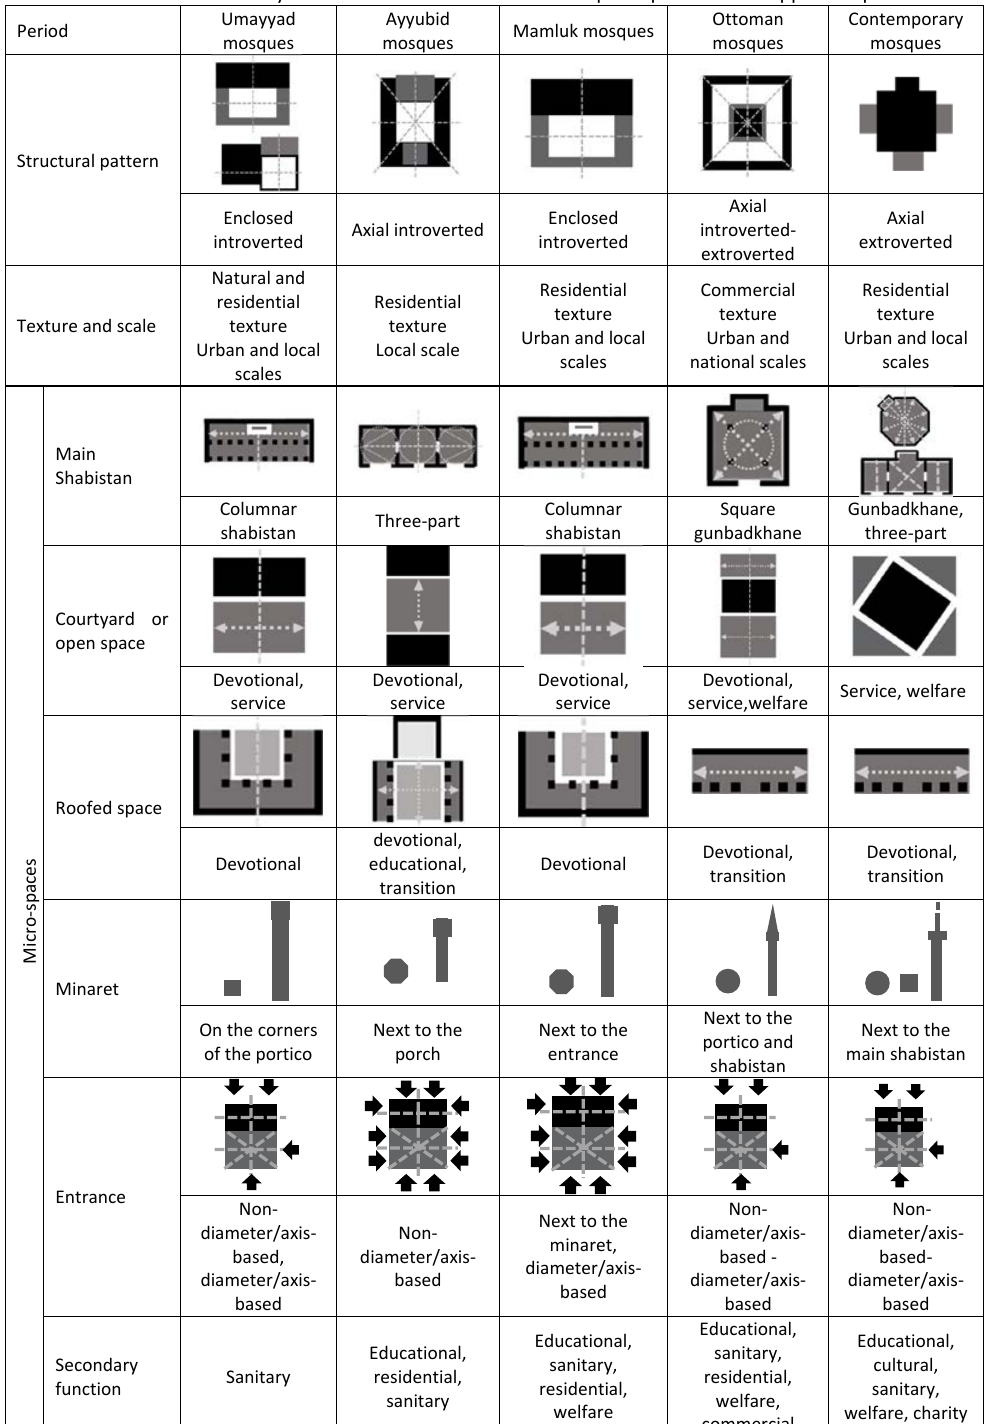
Table 5: Summary of the evolution of structural and spatial patterns in Aleppo mosques Period